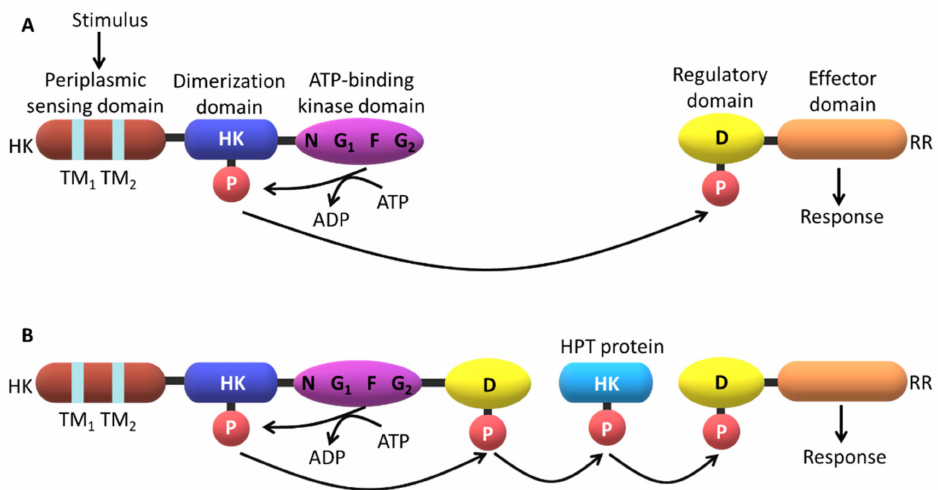
Figure 2. Phosphotransfer mechanisms in TCS. In both cases, the sensor domain detects the stimuli and regulates the histidine kinase domain (HK) activity. ( A ) Prototypical two-component pathway. The pathway consists of a dimeric transmembrane sensor HK and a cytoplasmic response regulator (RR) protein. A monomer of a representative HK is presented with transmembrane (TM) segments represented by TM 1 and TM 2 . N, G 1 , F and G 2 are conserved sequence motifs in the